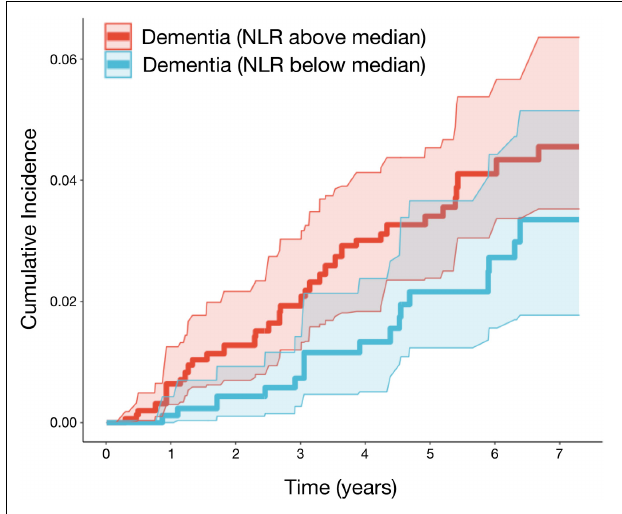
FIGURE 2 | The neutrophil to lymphocyte is associated with higher rates of incident dementia in the FHS. Adjusted cumulative incidence functions and 95% CIs for dementia for the NLR groups (defined as above/below median). Higher NLR at baseline was associated with a greater incidence of dementia. Models were adjusted for age, sex, BMI, systolic and diastolic blood pressure, diabetes, current smoking status, HDL, LDL, total cholesterol, triglycerides, and history of CVD ( n = 1,647; events = 51; median follow-up = 5.9 years). BMI, body mass index; LDL, low-density lipoprotein; HDL, high-density lipoprotein; CVD, cardiovascular disease; FHS, Framingham Heart